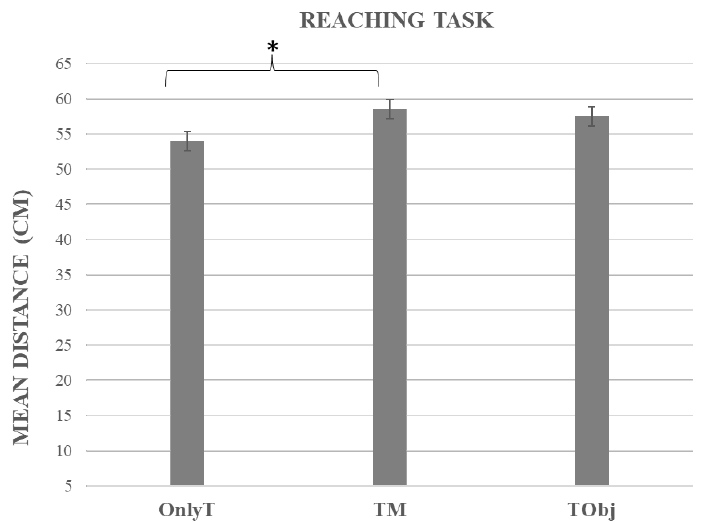
Figure 2. The graph shows the mean reaching distance (in cm) as a function of the three groups (OnlyT: Only Tool; TM: Tool plus Mannequin; TObj: Tool plus Object). The parenthesis and asterisk indicate experimental conditions that differ in approaching significance from each other. Error bars represent the standard error.